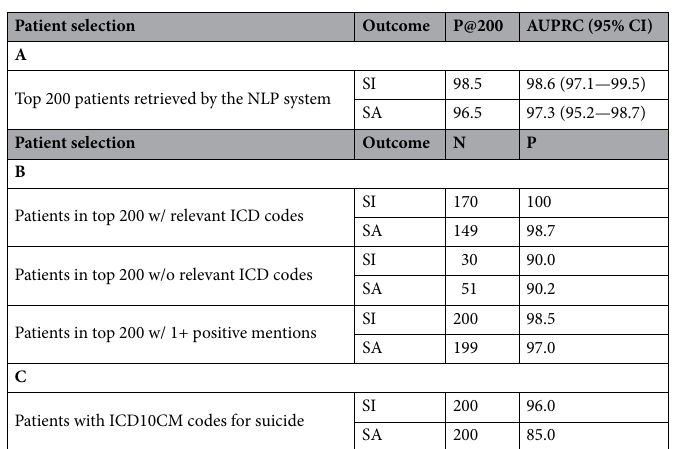
Table 2. NLP and ICD10CM validation. AUPRC area under the precision-recall curve, CI confidence interval, P@K precision at top K retrieved patients, P precision, SI suicidal ideation, SA suicide attempt.